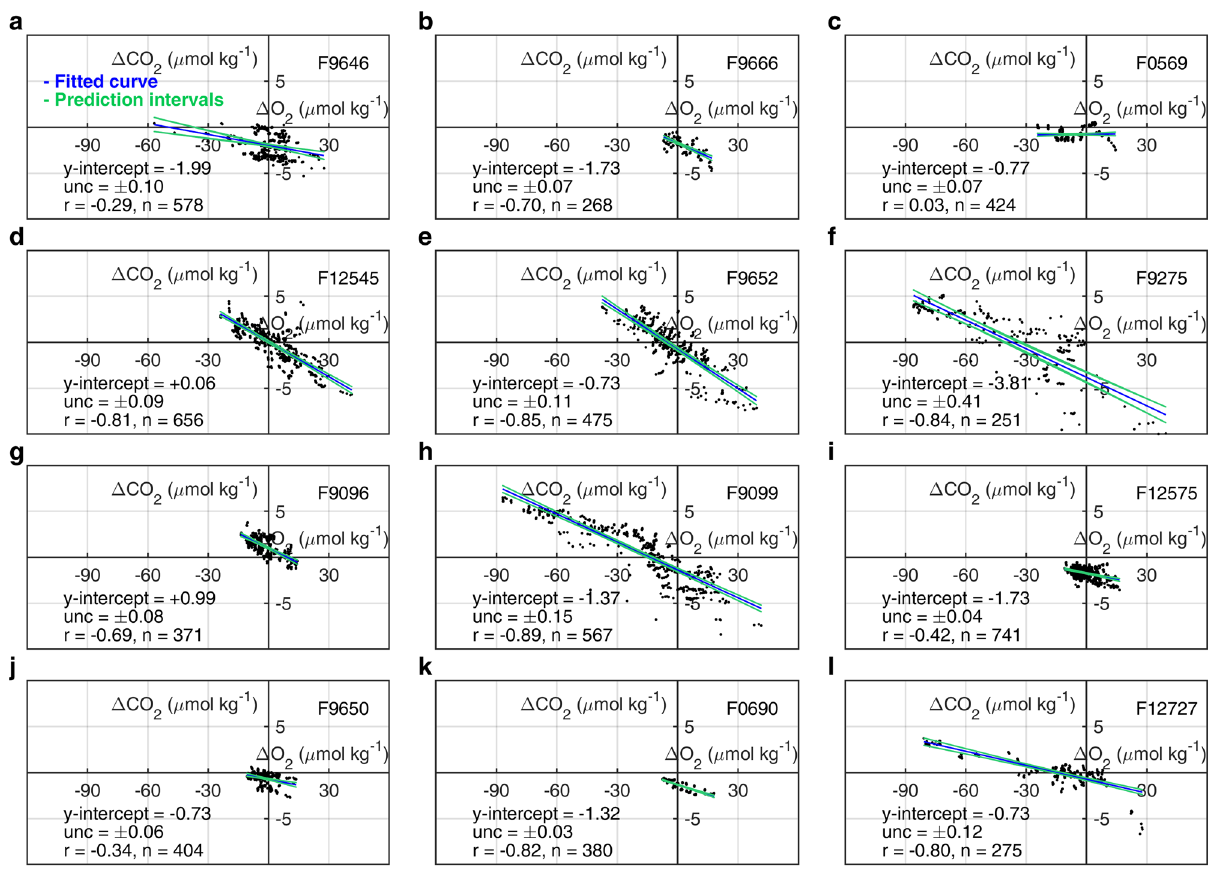
Fig. 6 CORS plots from data collected by 12 fl oats in the Southern Ocean. a – l F9646, F9666, F0569, F12545, F9652, F9275, F9096, F9099, F12575, F9650, F0690, and F12727, respectively. The blue lines are the least-squares best- fi t lines of data, green lines are the 95% con fi dence bounds for the fi tted coef fi cients (Table 1); unc denotes the uncertainty in y-intercept with 95% con fi dence level; r is the associated Pearson correlation coef fi cient; n is the number of data points. The label on the top right of each subplot denotes the UW fl oat ID number.